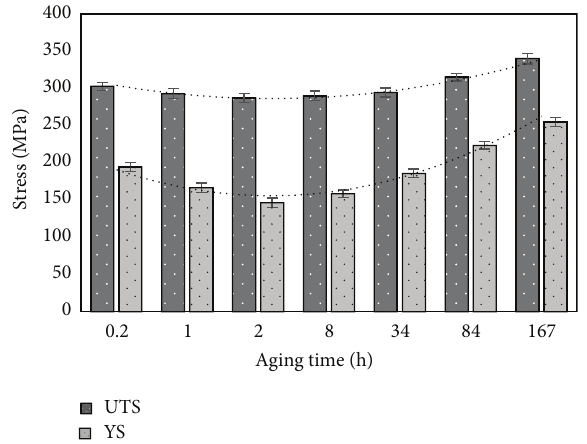
Figure 9: Measured tensile properties of AZ61 alloy with different aging